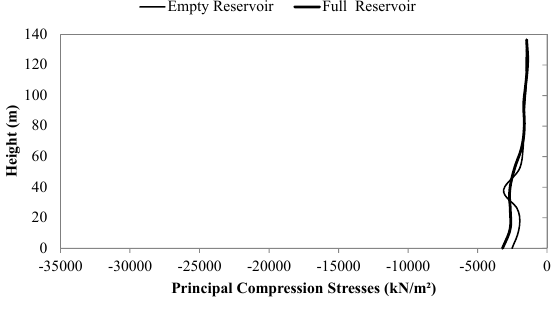
Fig. 24. The maximum principle stress components in VI-VI section.